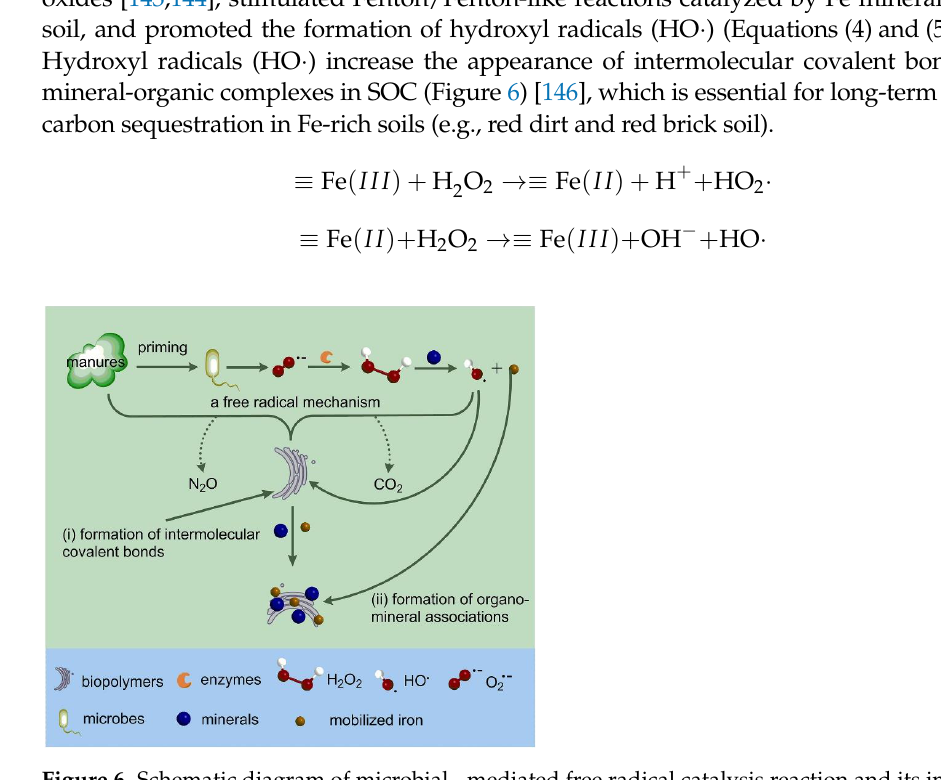
Figure 6. Schematic diagram of microbial−mediated free radical catalysis reaction and its impact on soil carbon stability and storage. Reprinted with permission from Ref. [146]. Copyright 2019 Wiley.